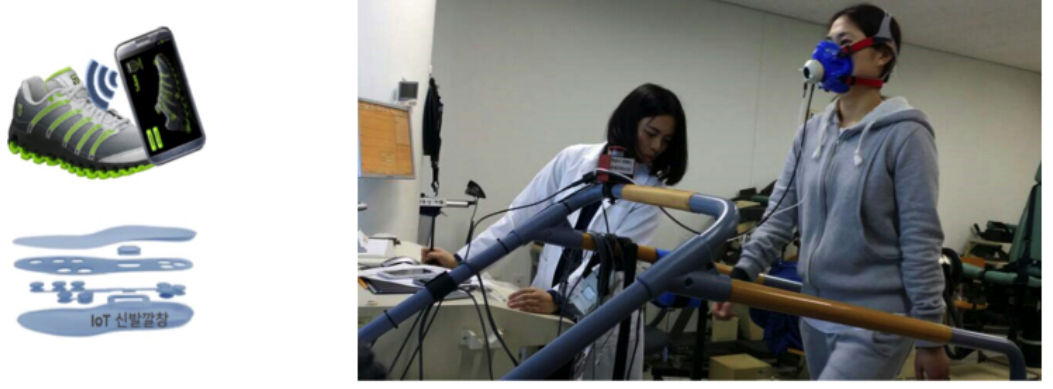
Figure 1. Illustration of the foot monitoring system (left) and a picture of a participant walking on an uphill treadmill wearing the K4b2 portable gas analyzer (right).